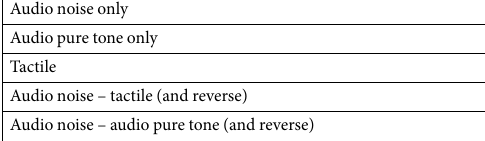
Table 1. Cross-modal flanker combinations.